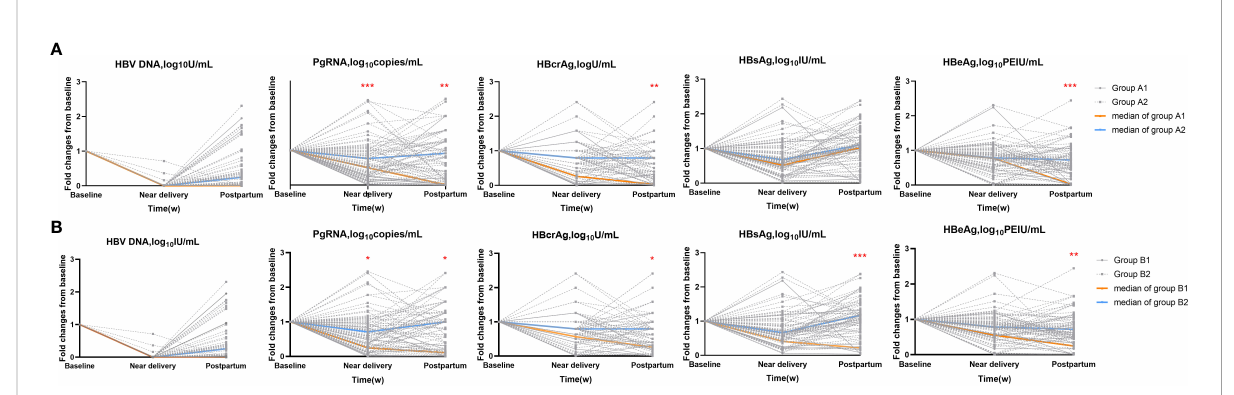
FIGURE 2 Fold changes of HBV markers in subgroups. (A) HBeAg seroconversion group (Group A1) and non-seroconversion group (Group A2). (B) HBsAg reduction (Group B1) and non-reduction group (Group B2). *=p < 0.05, **= p < 0.01, ***= p <